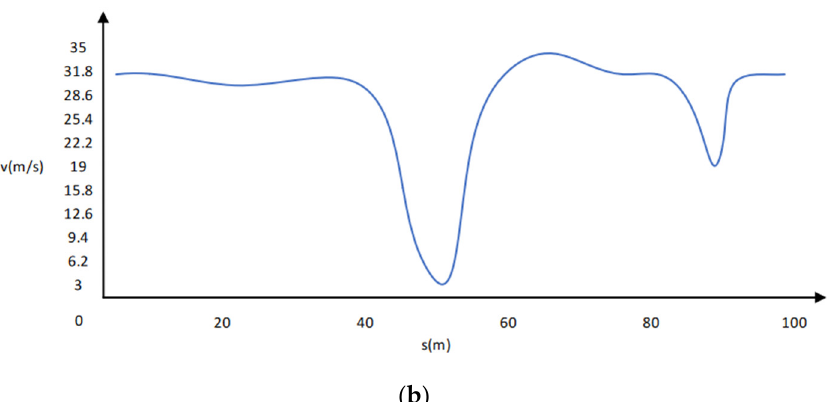
Figure 10. Dynamic path planning results for the U shape road with multiple challenges. ( a ) Vehicle overtakes the vehicles in front, takes two left turns, and waits for the green signal, ( b ) Speed Curve.